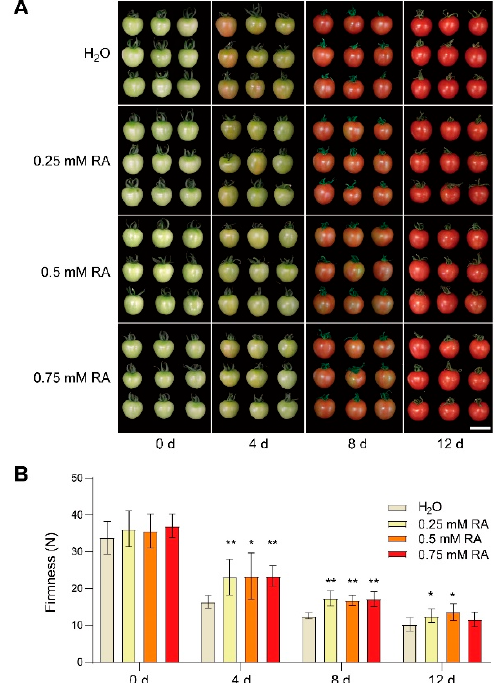
Figure 1. Rosmarinic acid (RA) postponed tomato fruit ripening. ( A ) The representative phenotype of tomato fruits at different days after RA treatment. Tomato fruits at the mature green stage were treated with 0.25, 0.5, and 0.75 mM RA, or H 2 O control. Bar = 2 cm. ( B ) Effect of RA on the fruit firmness at 0 d, 4 d, 8 d, 12 d after treatment. The data in ( B ) are presented as mean values ± SD; n = 9. Asterisks in ( B ) indicate statistically significant differences (* p ≤ 0.05, ** p ≤ 0.01) compared with control under the same time point, as determined by Student’s t -test.